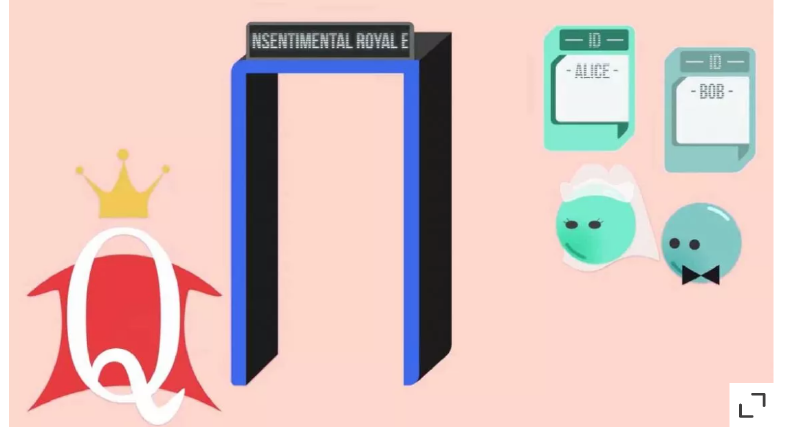
Figure 3. In the Quantum Pill about “entanglement” the correlation between two particles is pictured as an (unsentimental)